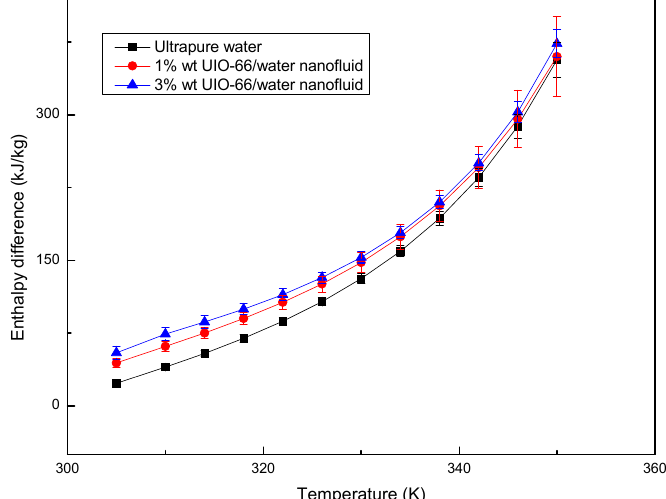
Energies 2019 , 12 , x FOR PEER REVIEW Figure 4. Enthalpy difference of ultrapure water and UIO-66/H 2 O nanofluids measured by TG-DSC. Figure 4. Enthalpy di ff erence of ultrapure water and UIO-66 / H 2 O nanofluids measured by TG-DSC.